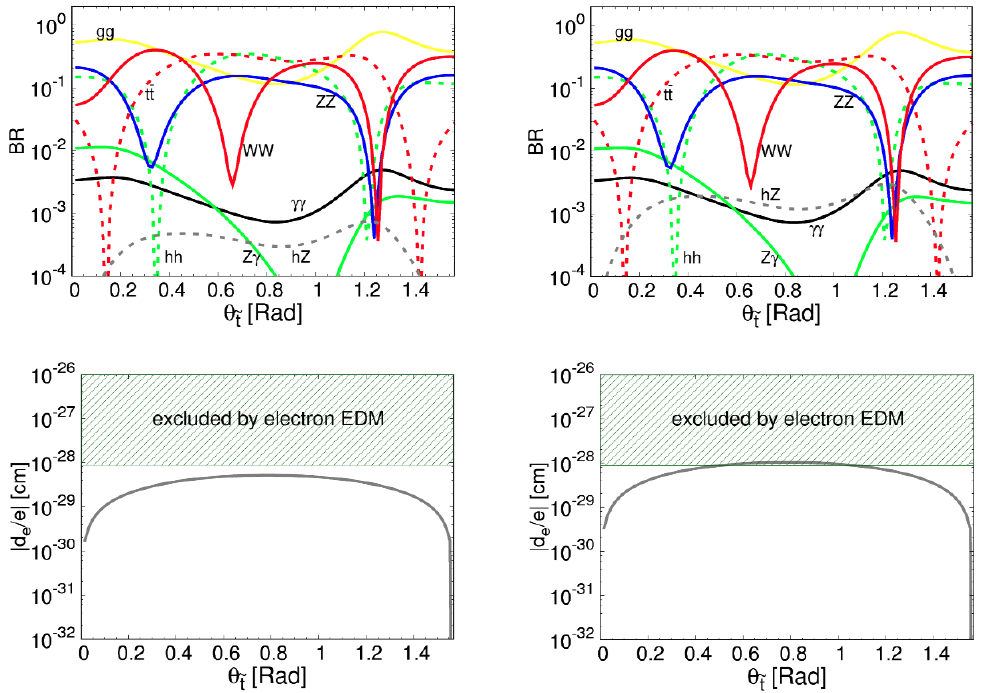
Figure 2 . Upper panels show the branching ratios of the stoponium with the corresponding predictions for the predicted eEDM from the two-loop Barr-Zee diagrams shown in the lower